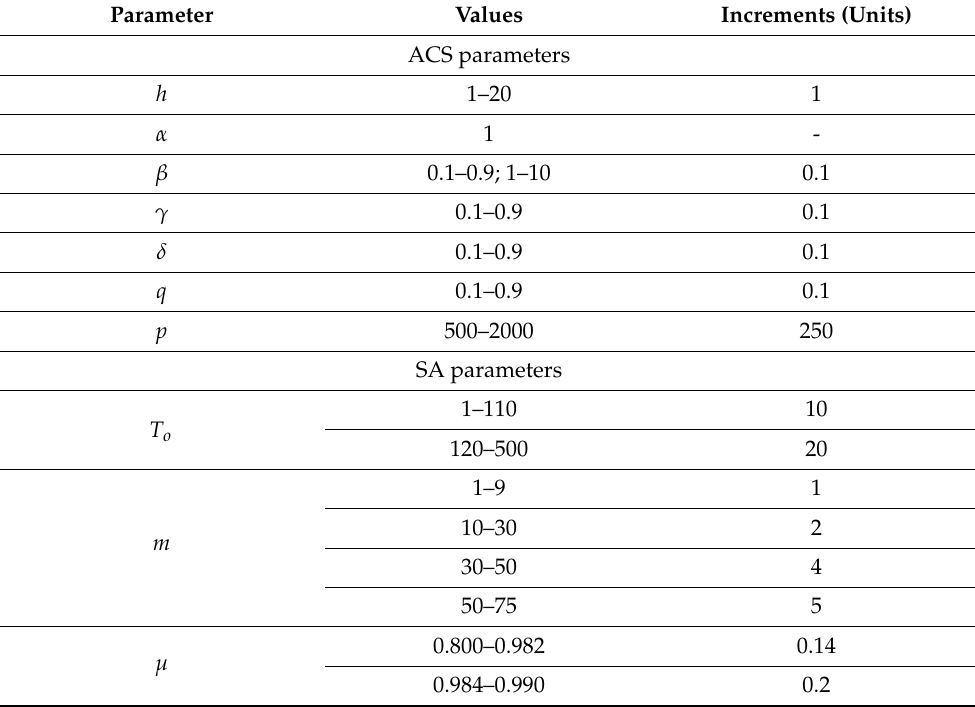
Table 3. Values for tuning ACS, SA, and